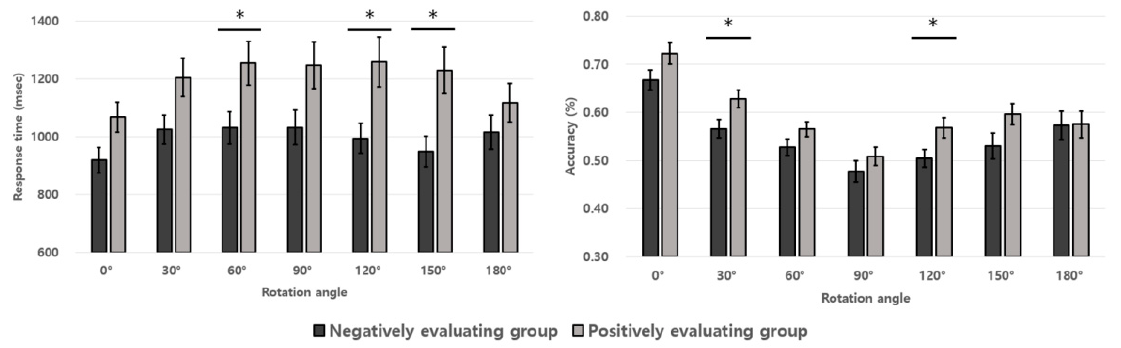
Figure 3. Response times and accuracy rates of two experimental groups in the performance of the mental rotation task. Error bars represent the standard error. (* p < 0.05). Table 2. The accuracy rates and response times for the two experimental groups in the mental rota- tion task. The values in parentheses denote the standard error. Degree of Rotation